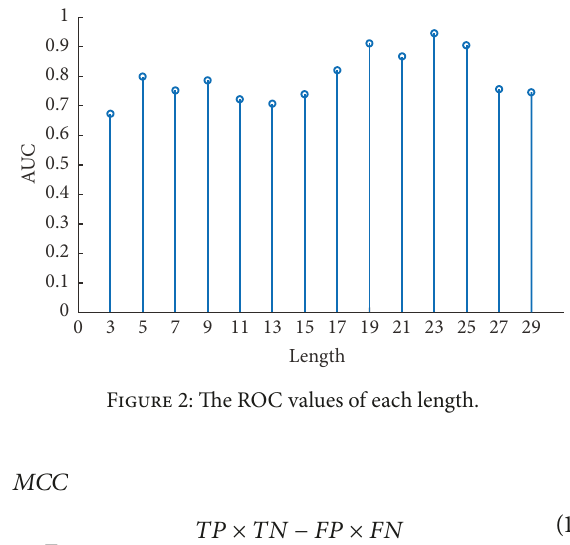
Figure 2: The ROC values of each